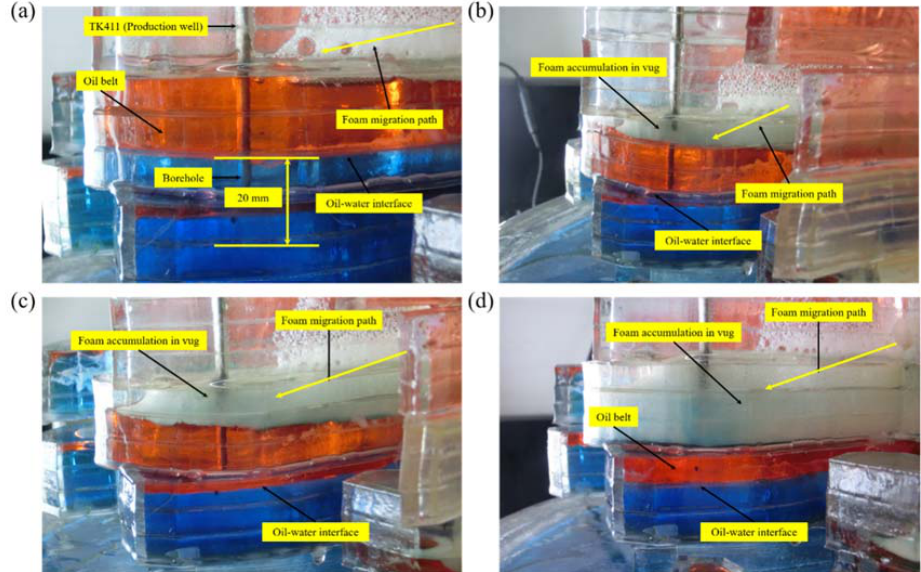
Figure 5. Foam flow characteristics around production well TK411: ( a ) Migration of Foam, ( b ) Accumulation of N 2 foam, ( c ) Further accumulation of N 2 foam, ( d ) Migration of oil belt.